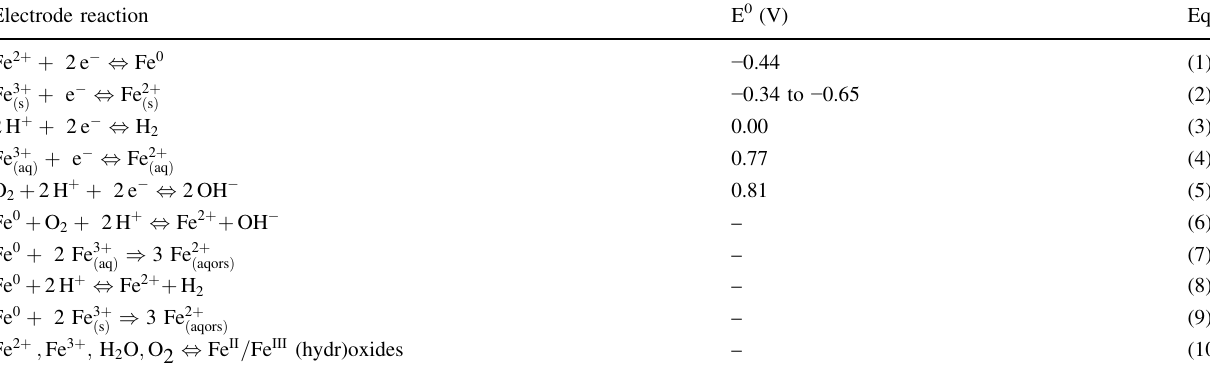
The resulting chemical reactions implying Fe 0 are specified of which only Eq. 8 and Eq. 9 are electrochemical in nature. Fe 0 oxidation after Eq. 9 is not likely to be quantitative. The reaction after Eq. 6 is not possible/quantitative because the Fe 0 surface is not accessible to O 2 . O 2 is reduced rather by Fe II species (Eq. 2 and Eq. 4). Electrode potential values are given versus the Standard Hydrogen Electrode (SHE)